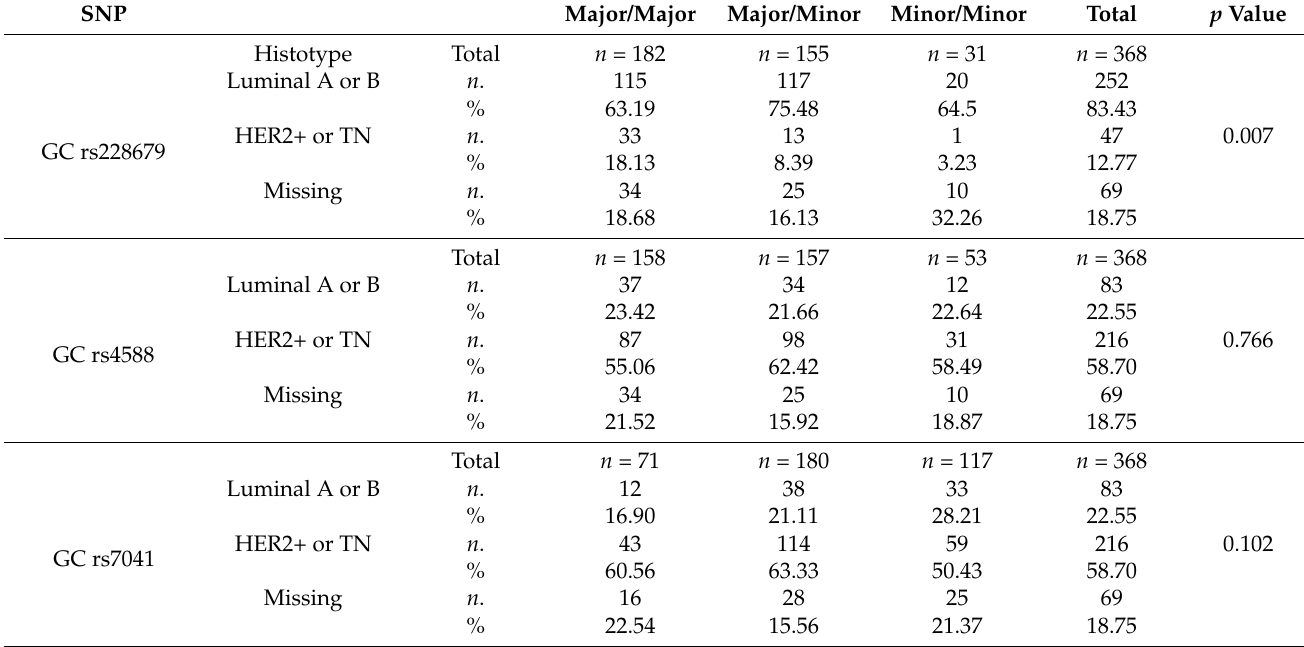
Table 3. GC SNPs variants frequencies by breast cancer molecular